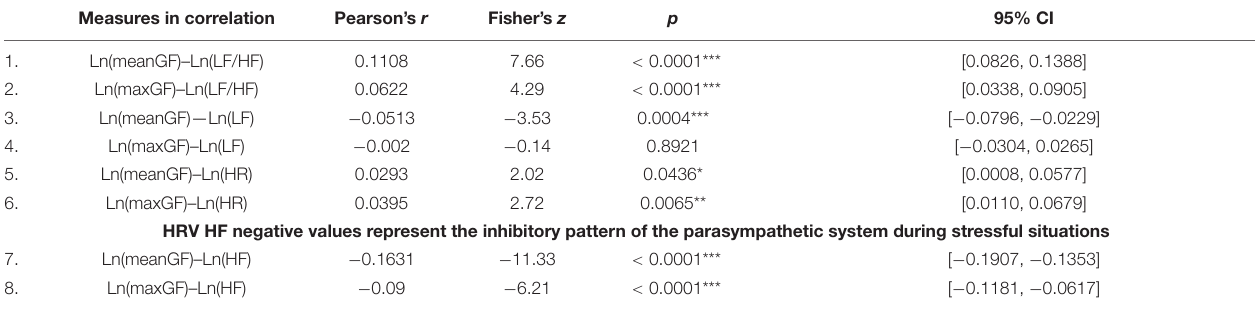
TABLE 2 | Summary of meta-analyses of correlations, for all k =